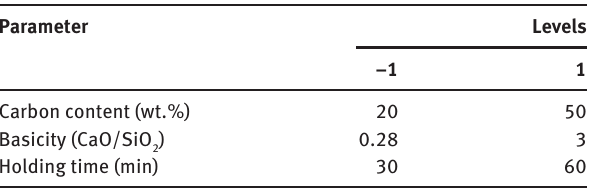
Table 1: Parameters and their levels used for the response surface design.